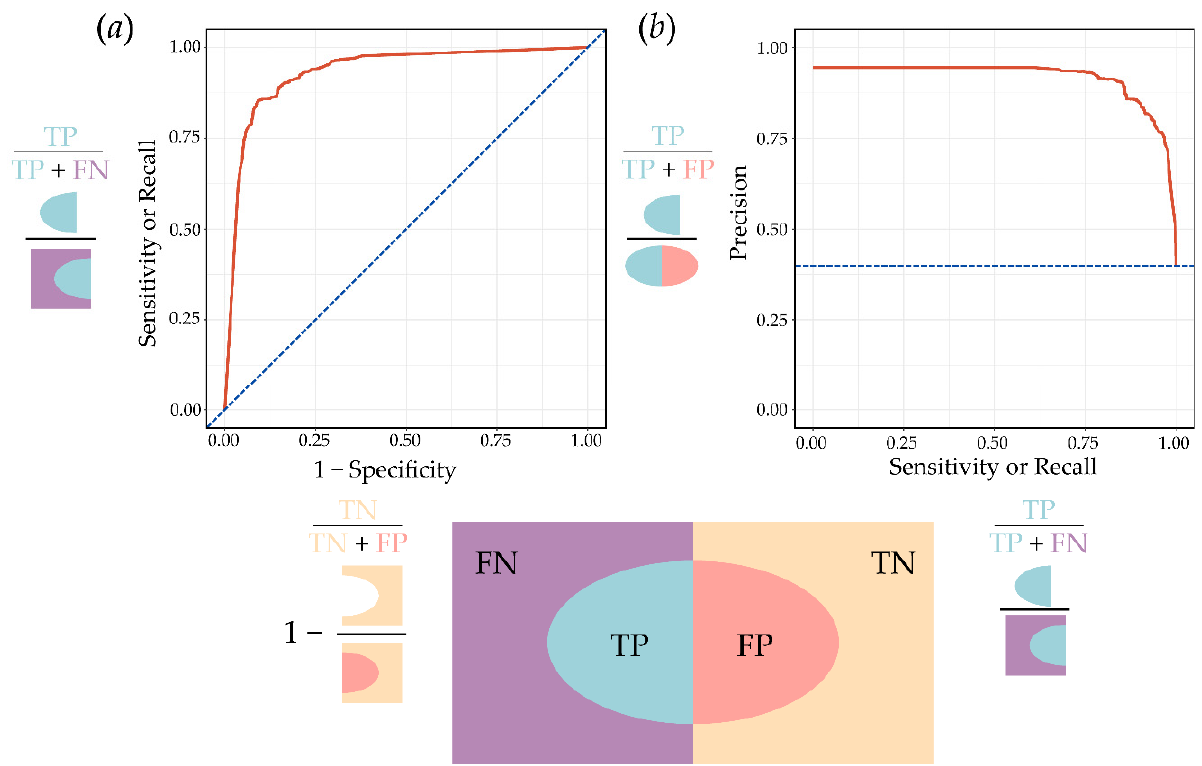
Figure 7. Methods for evaluating classifier performance over a range of thresholds: ( a ) ROC curve for a classification with an AUC ROC of 0.93; ( b ) P-R curve.